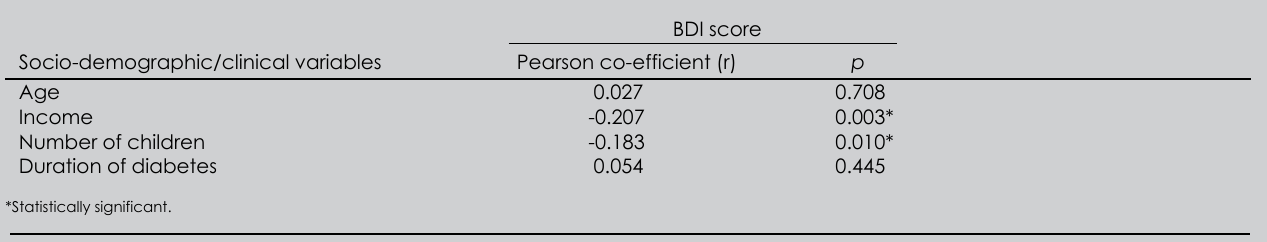
Table II. Correlation between some socio-demographic and clinical characteristics and BDI score